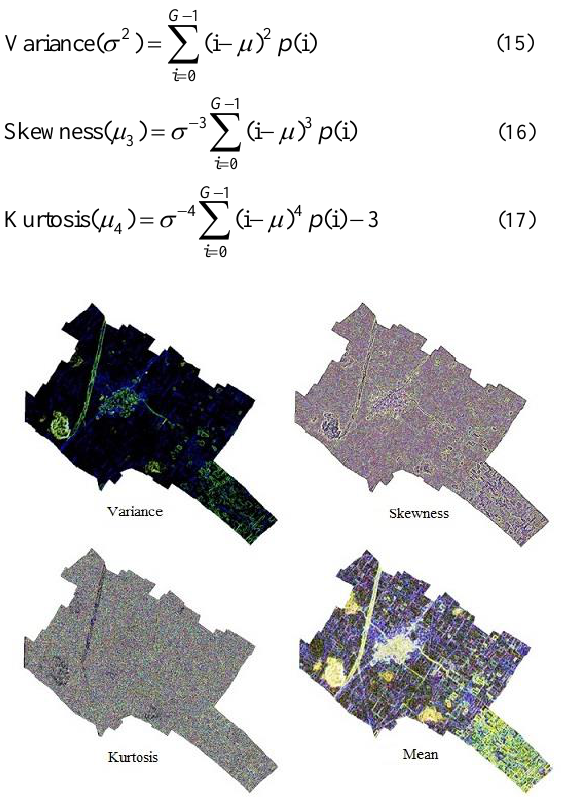
Figure 6. Generated texture images